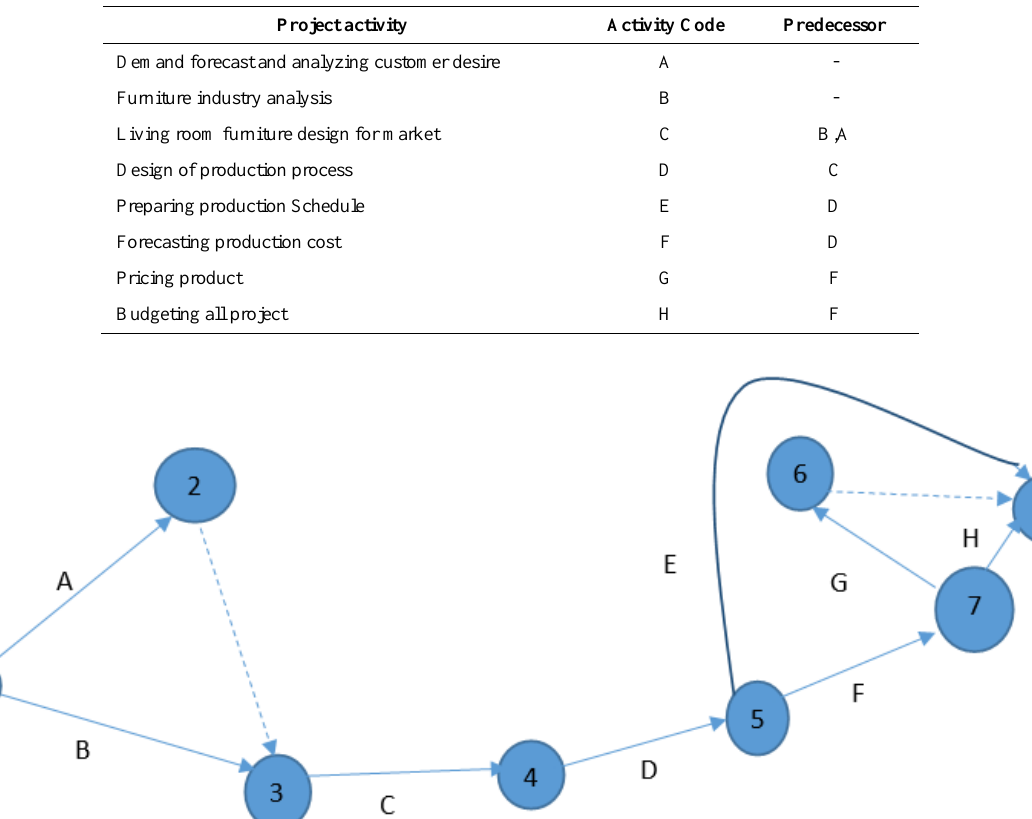
Table 9. Activity relationship table of project.